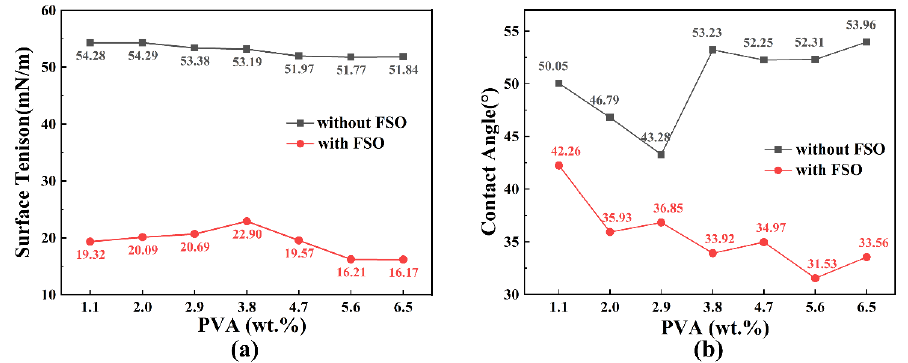
Figure 2. Precursor solutions: ( a ) surface tension, ( b ) contact angle at 20 s.